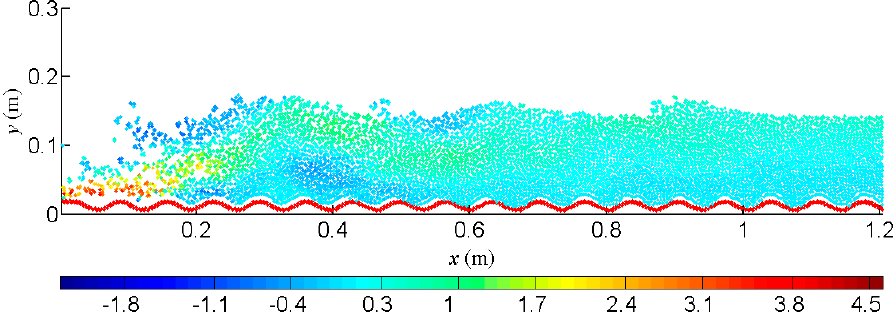
Figure 6. Contour of horizontal velocity of Case A.